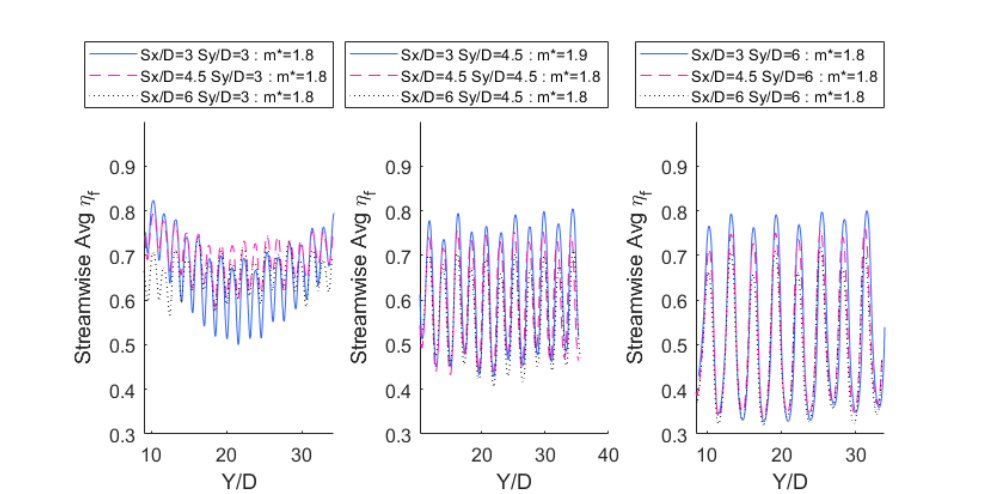
Figure 13. Streamwise-average film effectiveness for m ∗ ≈ 1.8. In each individual plot, geometries with constant S y are